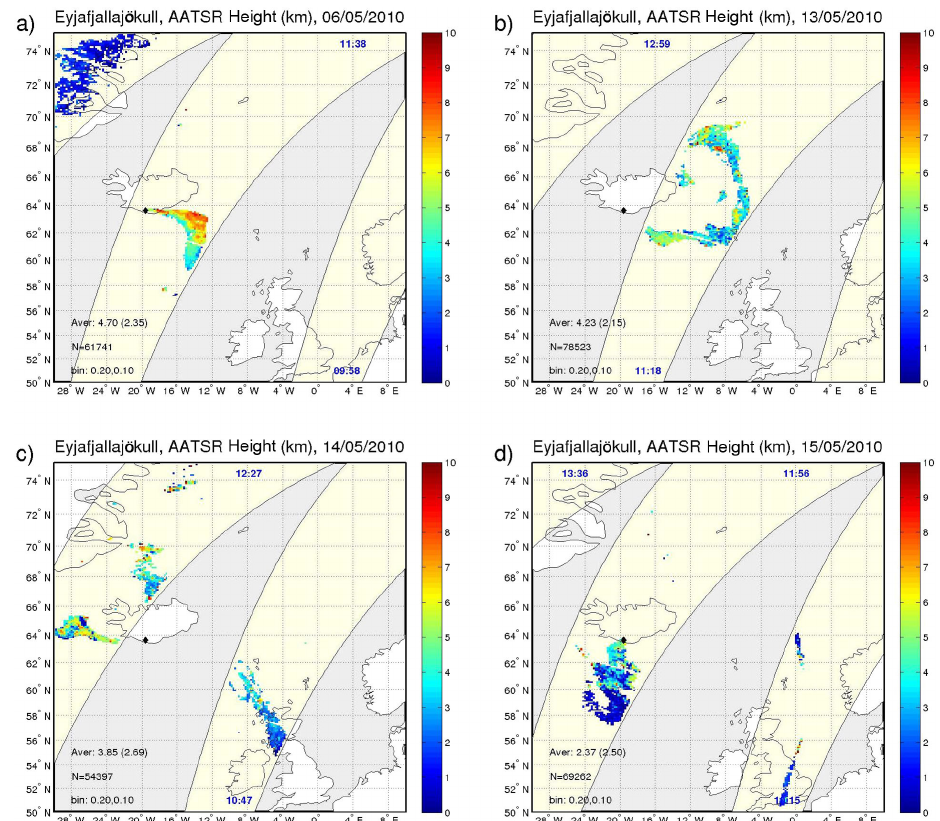
Figure 14. Single-pixel height for selected plumes on 4 days in May 2010. The yellow shaded areas show the AATSR swath, with the blue numbers giving the UTC time of the orbit. The color-coded pixels give the ACM height estimate (kma.s.l.). The text inserts in the lower left show the average height (standard deviation) and the number of pixels N in each